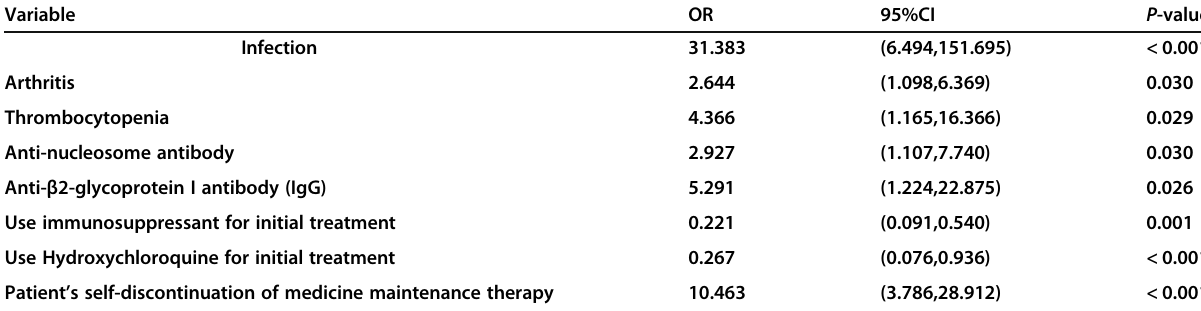
Table 2 Multiple logistic regression analysis of risk factors for SLE flare